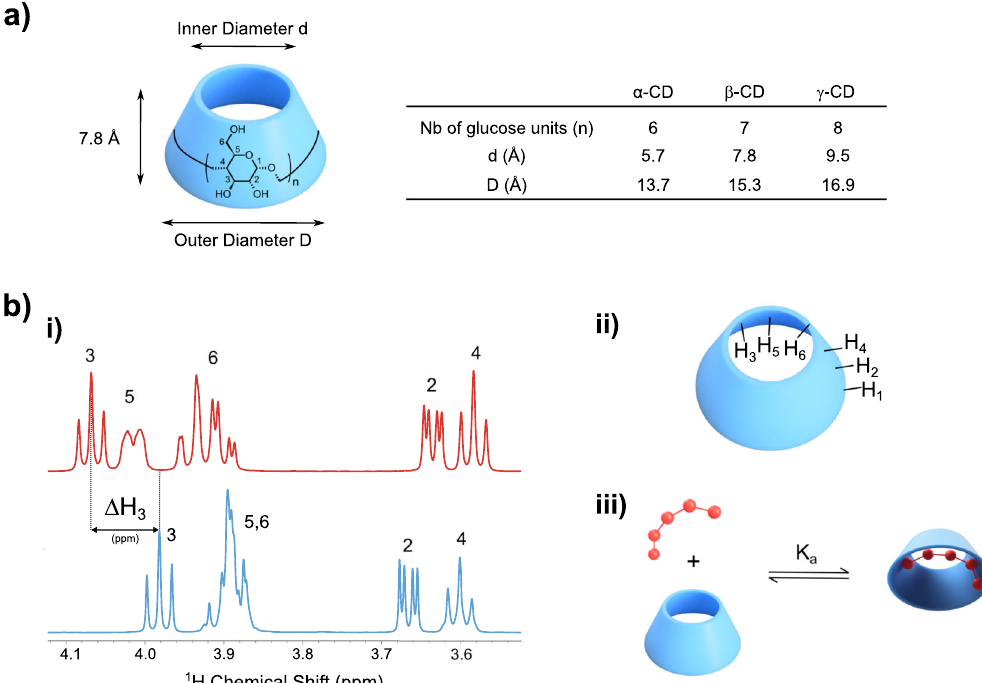
Fig. 1 1 H NMR demonstration of host-guest complexation between cyclodextrin and polysul fi des. a Chemical structures and geometric dimensions of α -cyclodextrins, β -cyclodextrins, and γ -cyclodextrins 52 . As macrocyclic ring molecules composed of, respectively, 6, 7, or 8 glucopyranoside units, α -cyclodextrins, β -cyclodextrins, or γ -cyclodextrins can adopt their cone-truncated conformation whose inner and outer diameters vary, respectively, from 5.7 to 9.5 Å and 13.7 to 16.9 Å 52 . The primary hydroxyl groups are located on the narrower rim of the molecule and the secondary ones are on the wider one. b (i) Selected region of the 1H NMR spectra (600 MHz, D 2 O, 298 K, pH 10, 25 mM NaHCO 3 ) of native β -cyclodextrin (10 mM, blue) and β - cyclodextrin in presence of Na 2 S 5 (equimolar ratio 10 mM, red) illustrating the host-guest interaction. (ii) Schematic location in the cyclodextrins 3D- structures of the hydrogens shown in the NMR spectra. (iii) Schematic representation of the host-guest interaction equilibrium between β -cyclodextrin and Na 2 S 5 (Na + counter ions were not represented for better